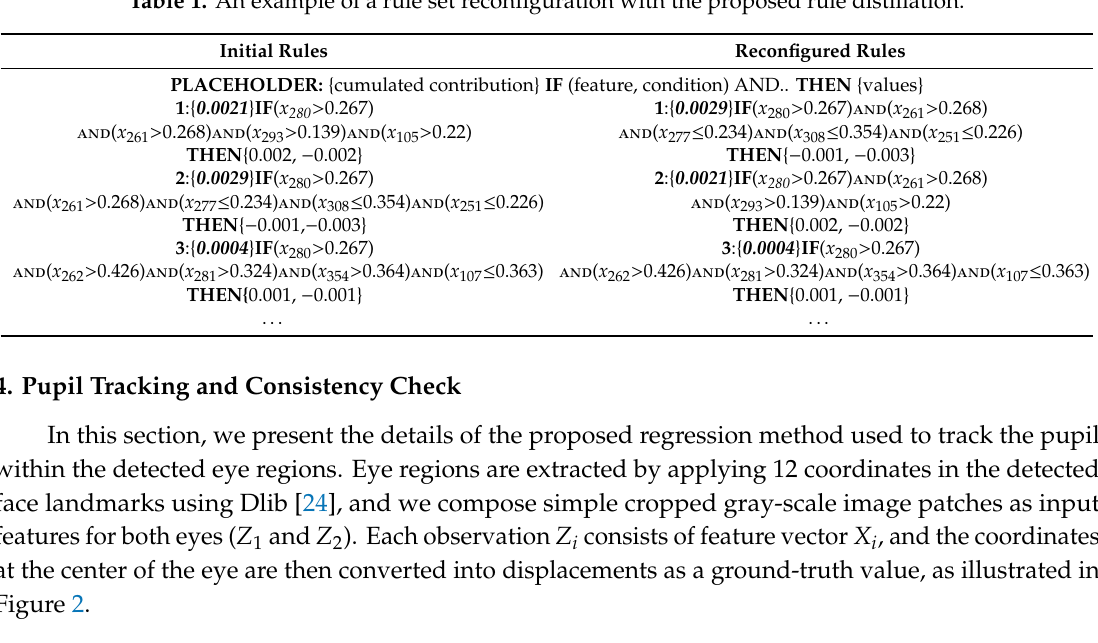
Table 1. An example of a rule set reconfiguration with the proposed rule distillation. Initial rules Reconfigured rules